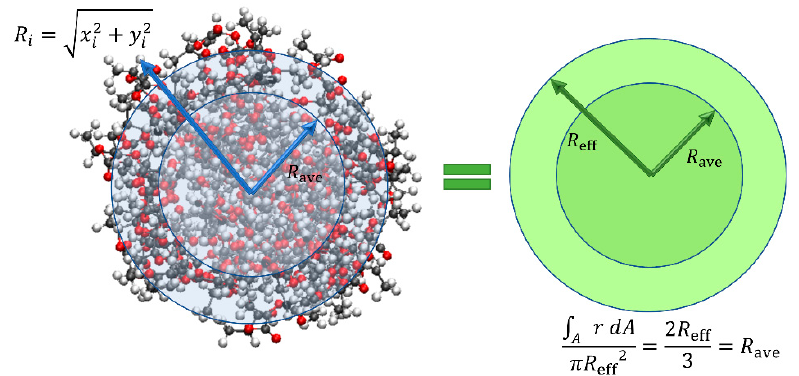
Figure 6. Determination of effective